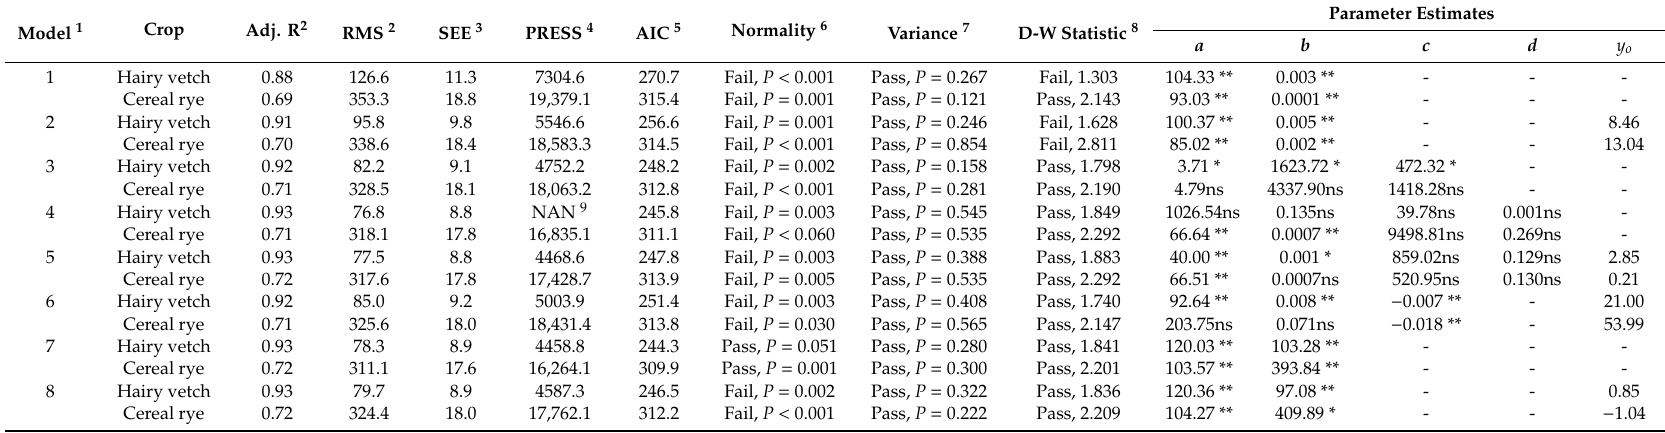
Table 2. Evaluation of models used to describe percent mass remaining of belowground biomass of hairy vetch and cereal rye cover crops at Exp. 1 in 2015. Data were from no-till plots at Carbondale,